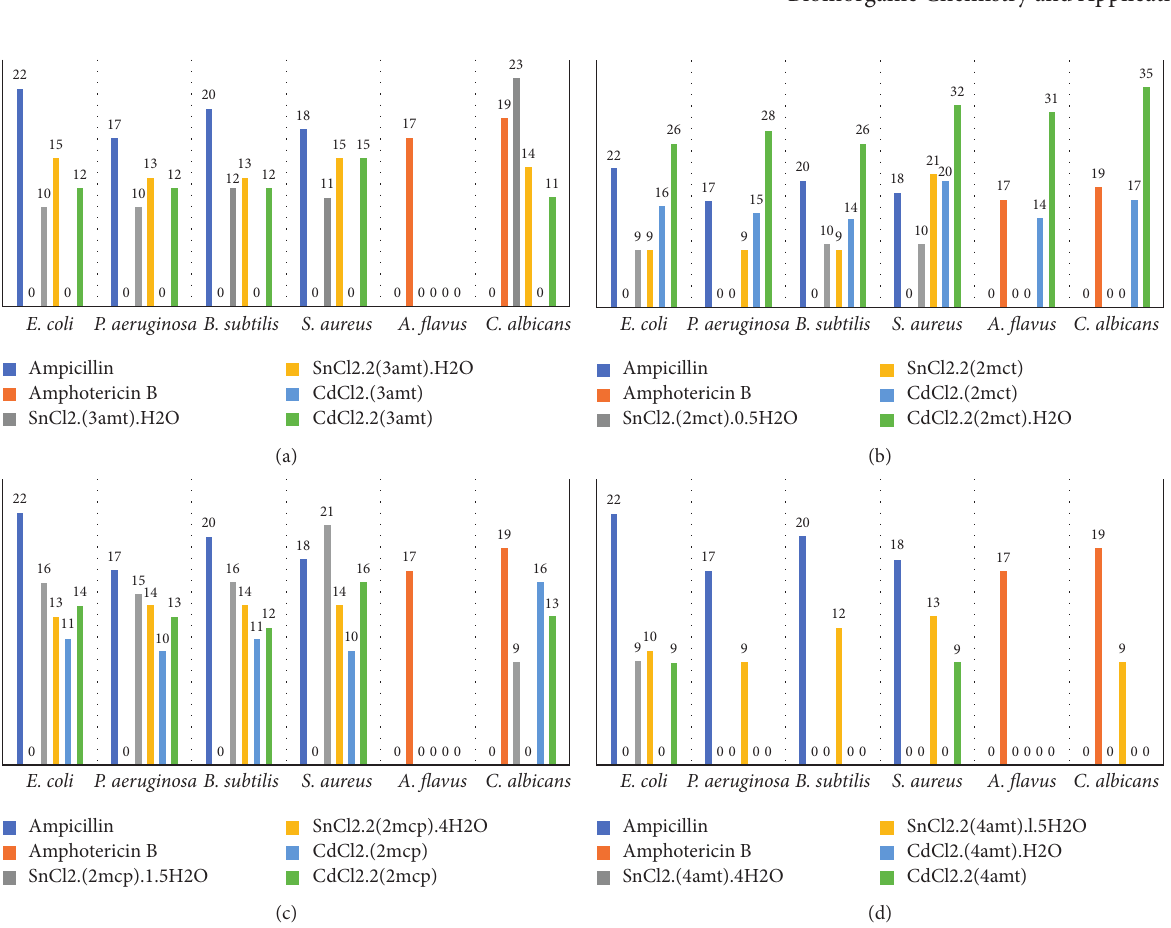
Figure 5: The antimicrobial effects of the 16 solid adducts. The number above the column indicates the inhibition zone